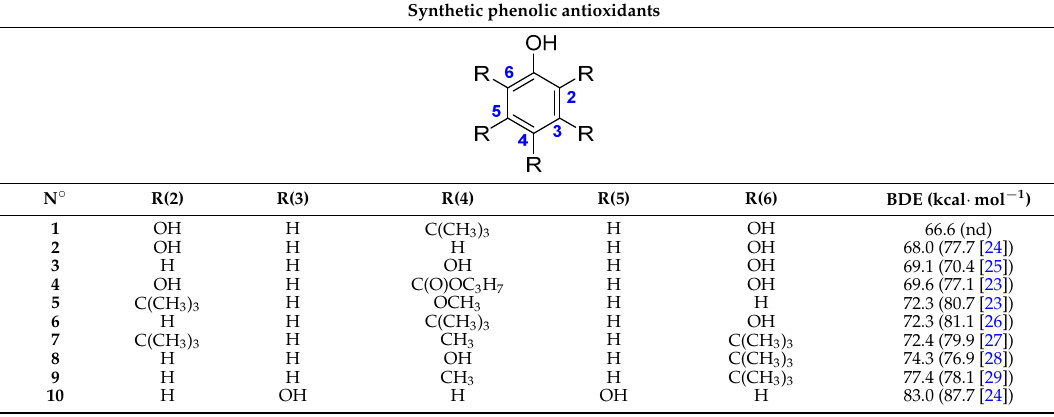
Table 2. Bond dissociation enthalpies (BDEs) for the phenolic antioxidants studied ( 1 – 70 ). Synthetic phenolic antioxidants